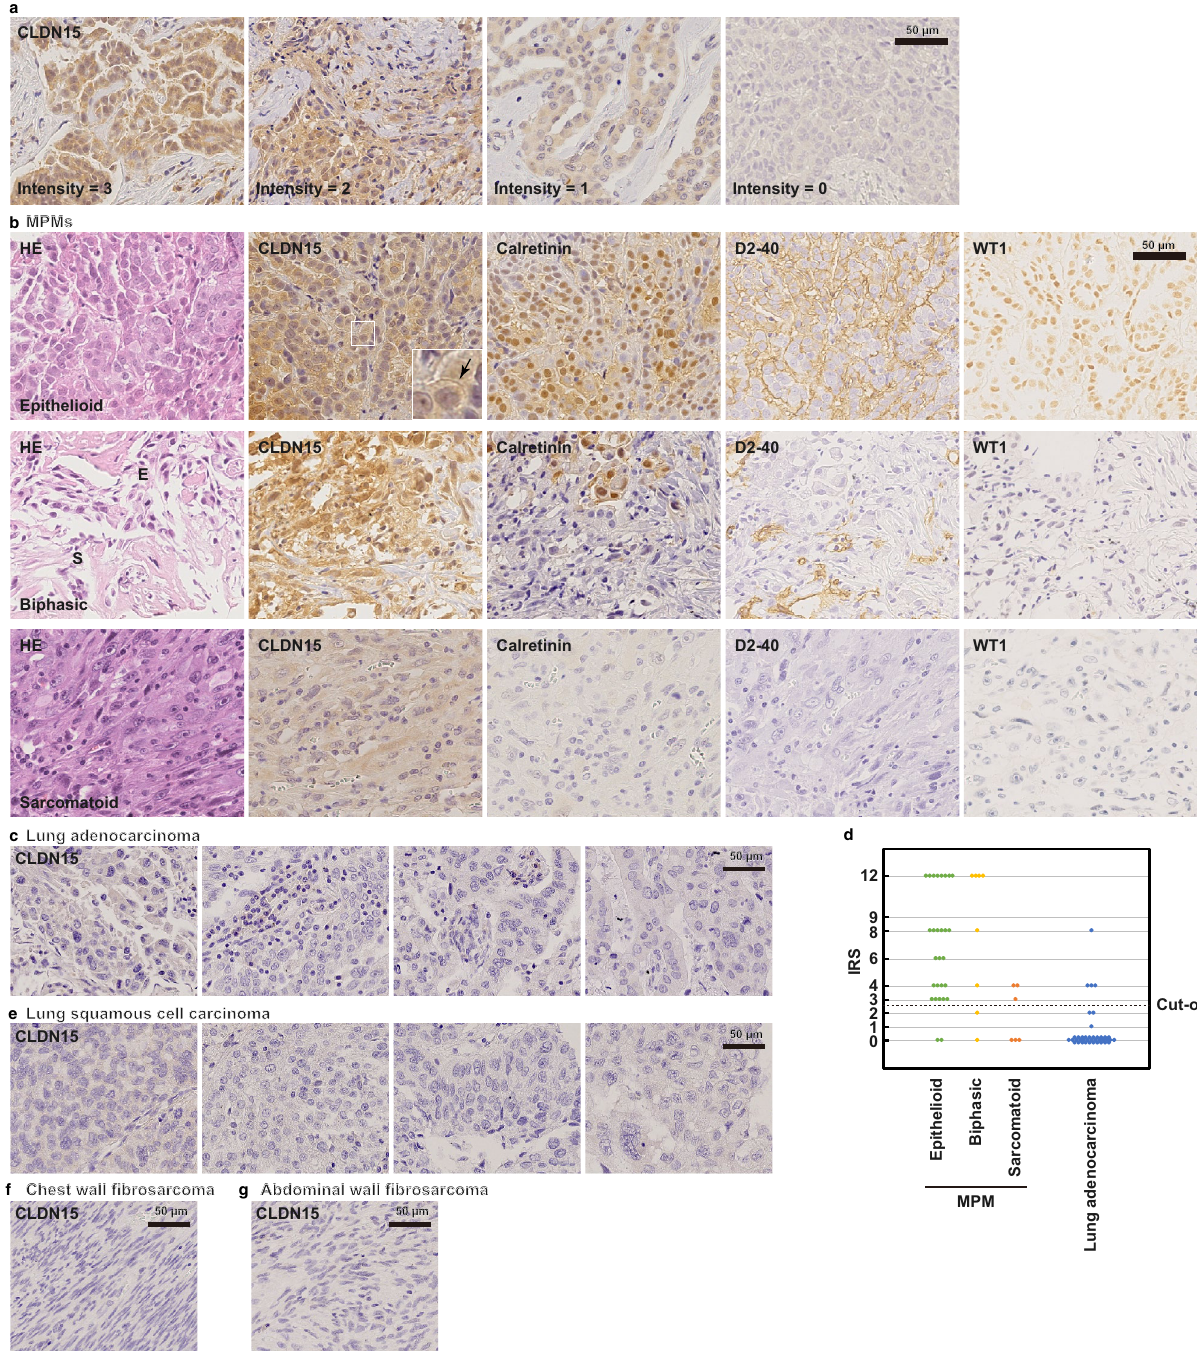
Figure 3. CLDN15 is expressed in MPM tissues. a Typical staining patterns of anti-CLDN15 (2C11) mAb exhibiting strong to weak staining intensities. Scale bar, 50 µm. b IHC of epithelioid-, biphasic- and sarcomatoid-type MPMs using anti-CLDN15 (2C11), anti-calretinin, anti-D2-40 and anti-WT1 antibodies. “E” and “S” in the HE staining panel of the biphasic-type MPM indicate the epitheliod-type and sarcomatoid- type cell regions, respectively. c IHC of lung adenocarcinomas using anti-CLDN15 (2C11) mAb. d Distribution of IRS scores in MPMs and lung adenocarcinomas. e – g IHC of lung squamous cell carcinomas ( e ), chest wall fibrosarcoma ( f ) and abdominal wall fibrosarcoma ( g ) using anti-CLDN15 (2C11)